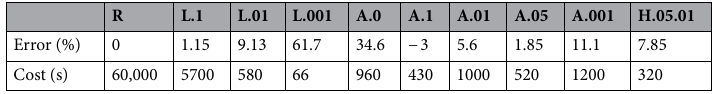
Table 2. Comparison between different time-mapping scenarios.